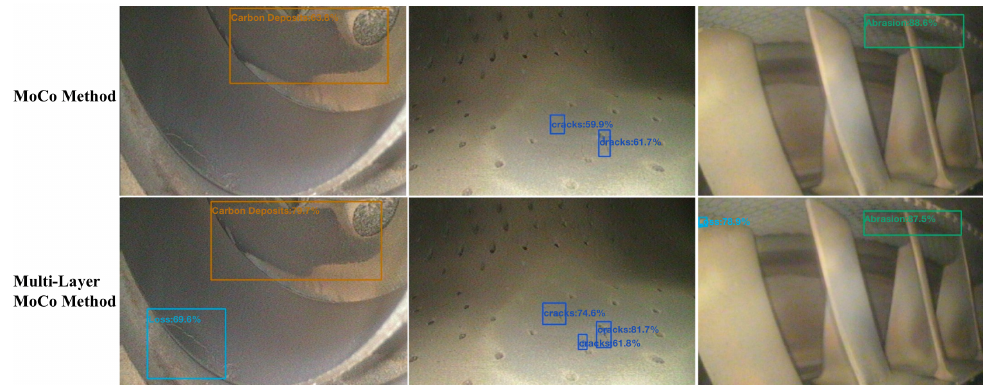
Figure 10. Visual comparison example between the multi-layer MoCo method and the MoCo method for the swirler, large elbow pipe, and air compressor/turbine blades. Our detection method is able to detect the damaged areas ignored by the other.